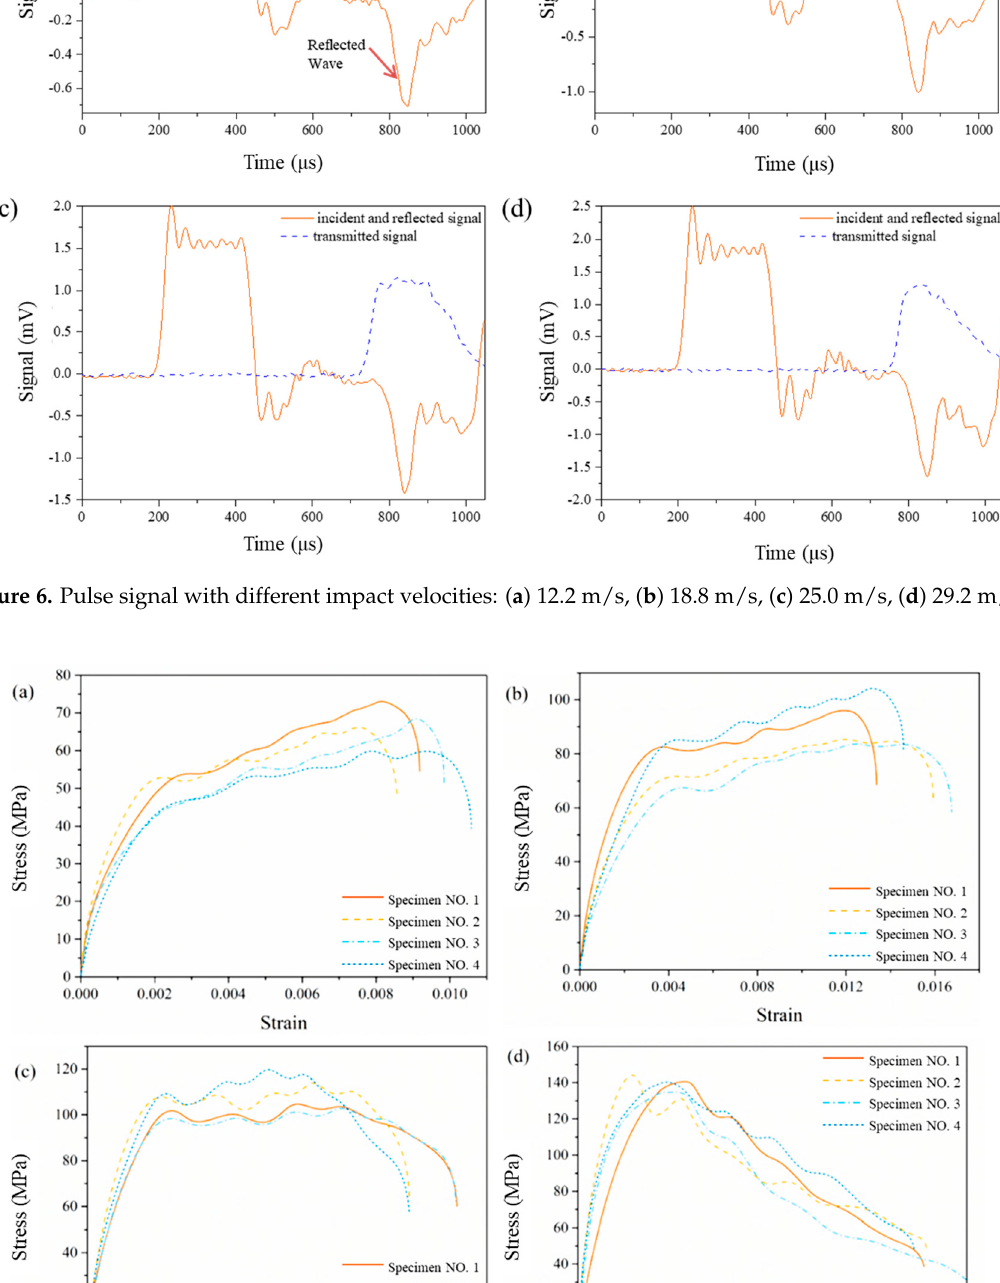
Figure 7. Compression Stress-strain curves of specimens without aging treatment under different impact velocities: ( a ) 12.2 m/s, ( b ) 18.8 m/s, ( c ) 25.0 m/s, ( d ) 29.2 m/s.